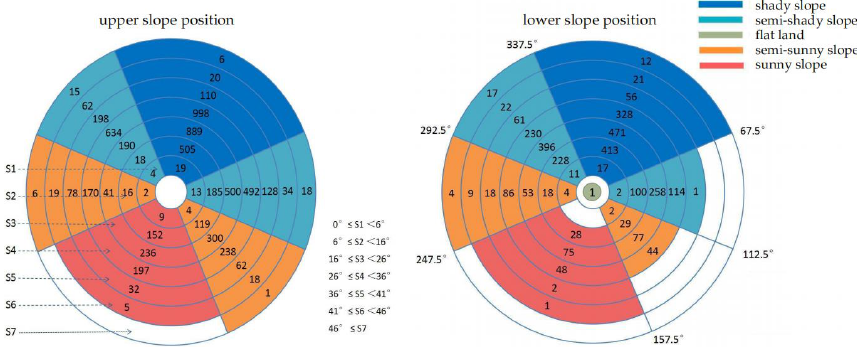
Figure 2. Quantity diagram of microtopographic samples.